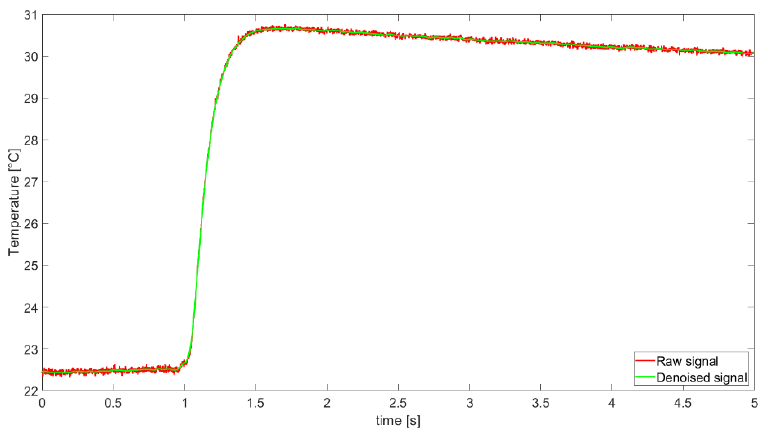
Figure 9. Inconel 601: raw and denoised signals.